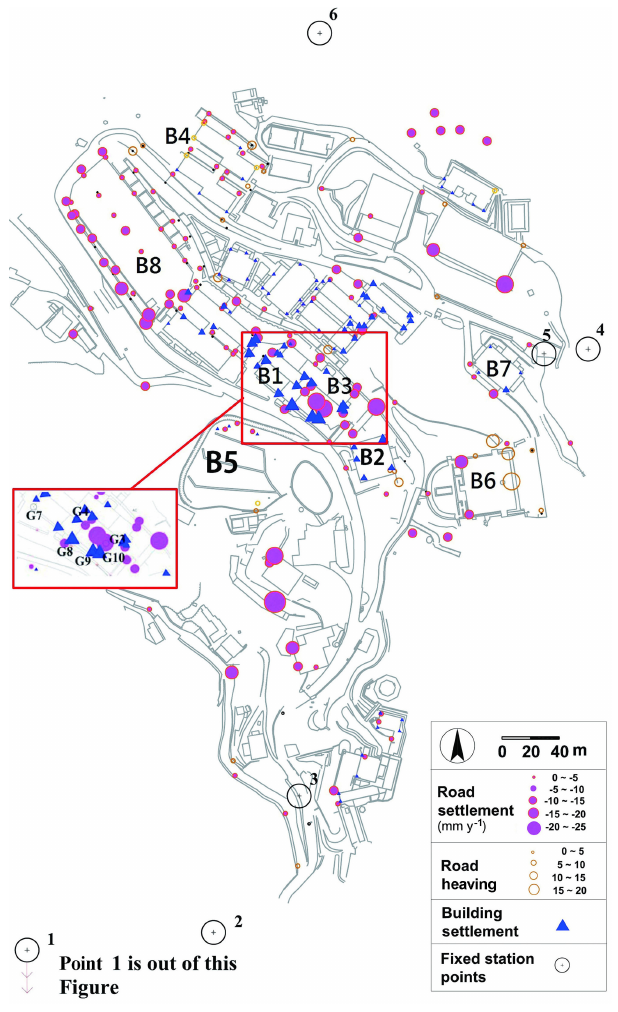
Figure 6. Ground settlement distribution within the campus. The settlement marks around buildings are denoted by solid triangles, the settlement marks for roads and other land areas are represented by solid circles, and the heaving points are indicated by hollow cir- cles.